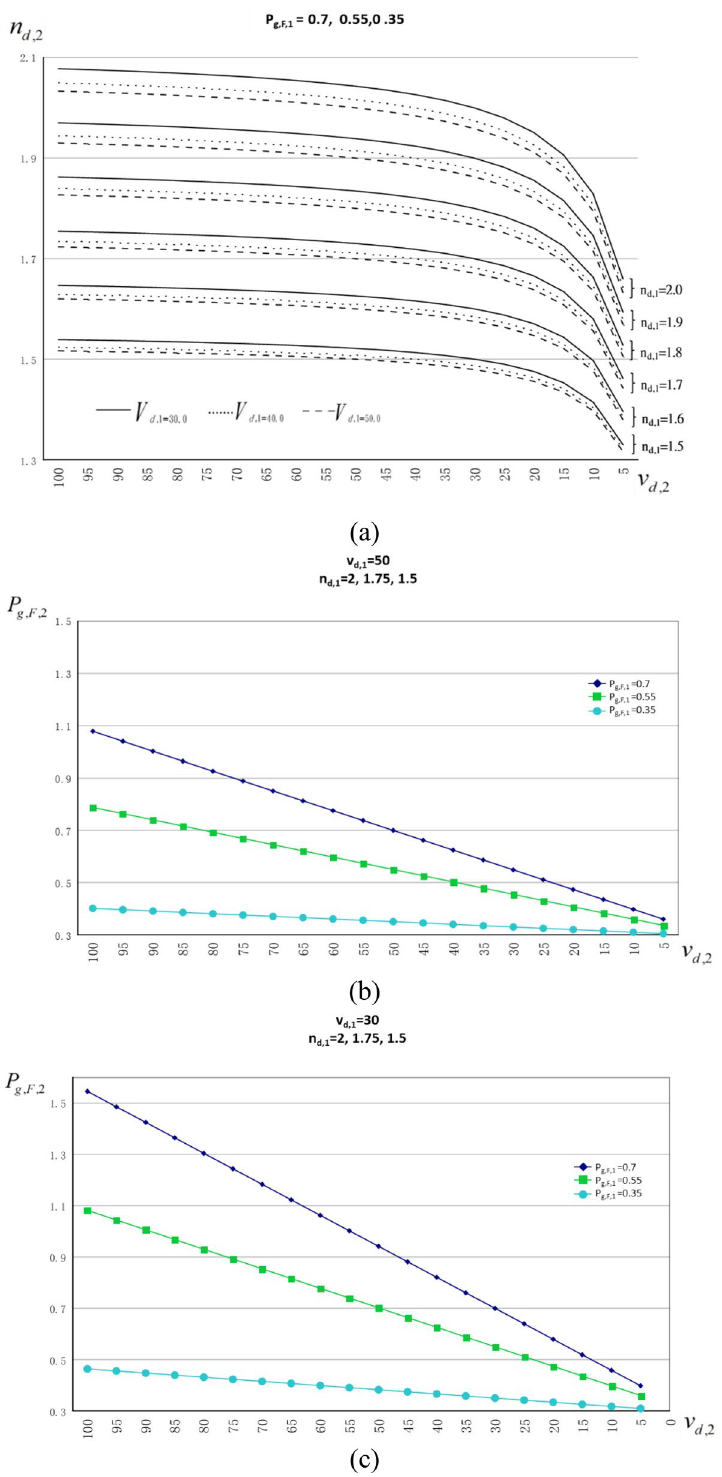
Figure 6. Dependence of n d,2 (v d,2 ) and P g,F,2 (v d,2 ). ( a ) n d,2 (v d,2 ) is dependent on n d,1 and v d,1 only but independent on P g,F,1 , where n d,2 is split into a subset of lines at v d,1 = 30, 40, 50 when n d,1 is fixed. ( b , c ) P g,F,2 (v d,2 ) is dependent on P g,F,1 and v d,1 only but independent on n d,1 where P g,F,2 is constant when n d,1 is varied in the wide range from 2 to